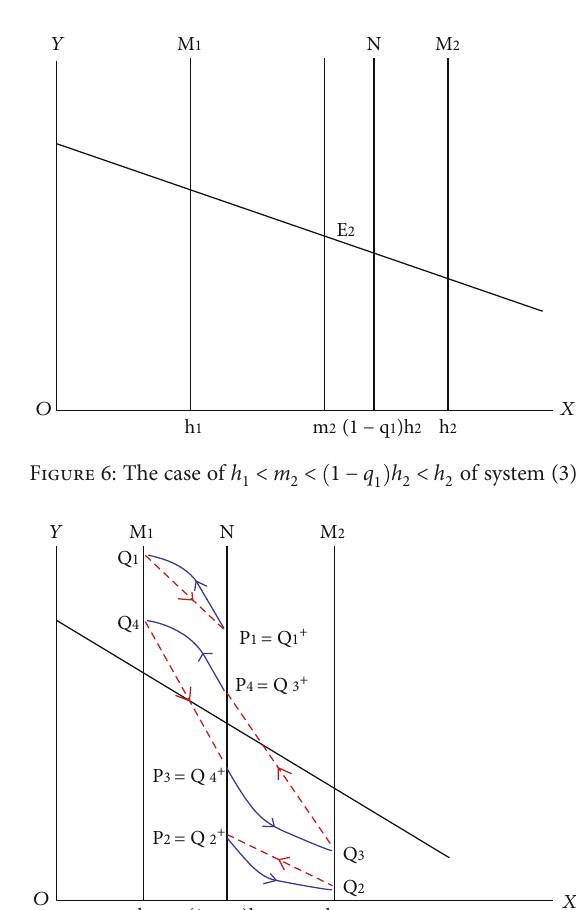
Figure 5: The case of h